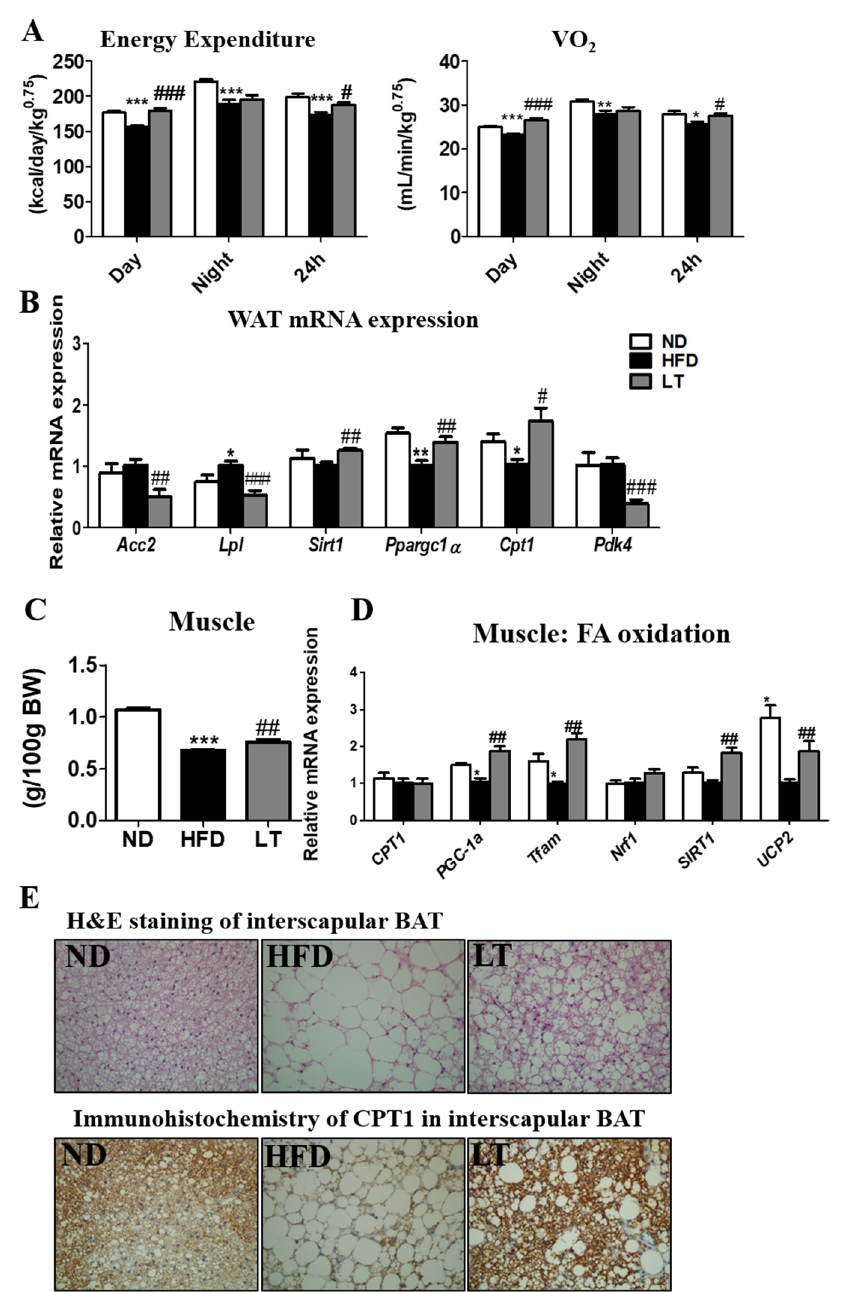
Figure 2. Effect of LT water extract supplement in diet-induced obesity on energy expenditure and VO 2 ( A ), WAT mRNA expression ( B ), muscle weight ( C ), muscle mRNA expression ( D ), epididymal white adipose tissue and interscapular brown adipose tissue morphology (200× magnification) ( E ); Data are the mean ± SE. Significant differences between HFD versus ND are indicated: * p < 0.05, ** p < 0.01, *** p < 0.001. Significant differences between HFD versus LT are indicated: # p < 0.05, ## p < 0.01, ### p < 0.001. ND, normal diet (AIN-93G); HFD, high-fat diet (60% kcal from fat); LT, HFD + Lycopus lucidus Turcz water extract (1.5%, w/w ); VO 2 , O 2 consumption; Acc2, acetyl-CoA carboxyl- ases; Lpl, lipoprotein lipase; Sirt1, Sirtuin1; Ppargc1a; peroxisome proliferator-activated receptor gamma coactivator 1-alpha; Cpt1, carnitine palmitoyl transferase1; Pdk4, pyruvate dehydrogenase kinase 4; ppara, peroxisome proliferator-activated receptor alpha; CD36, cluster of differentiation 36; Slc2a4, solute carrier family 2 member 4; PGC-1a, peroxisome proliferator-activated receptor gamma coactivator-1 alpha; tfam, transcription factor A, Nrf1, nuclear respiratory factor 1; UCP2; uncoupling protein